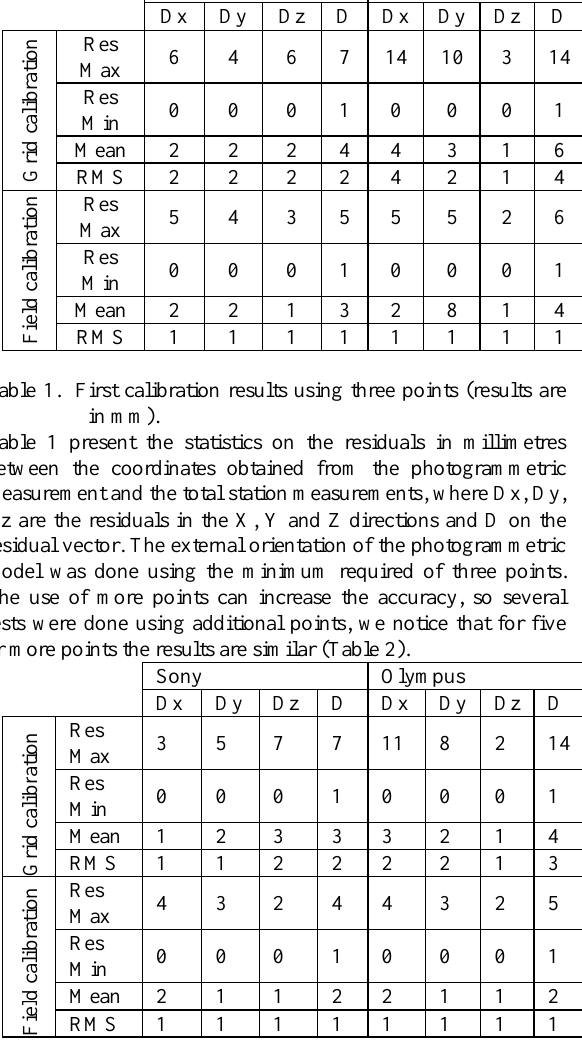
Table 2. Second calibration results using five points (results are in mm).